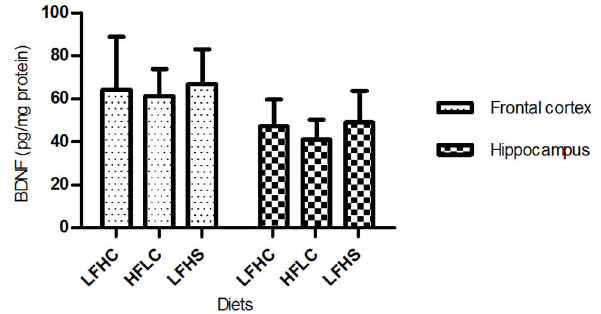
Figure 3. Brain-derived neurotrophic factor (BDNF) in tissue from frontal cortex and hippocampus. BDNF levels (pg/mg protein) are presented as means ±SD for minipigs fed low fat, high carbohydrate diet (LFHC); high fat/cholesterol, low carbohydrate diet (HFLC); low fat, high carbohydrate/sucrose diet (LFHS). doi: phase, LFHC and HFLC minipigs were able to learn to reverse their initial acquisition of the test, both improving their working memory scores and reference memory scores between the two trial blocks. The LFHS diet impaired working memory, as these minipigs performed significantly worse than LFHC minipigs by